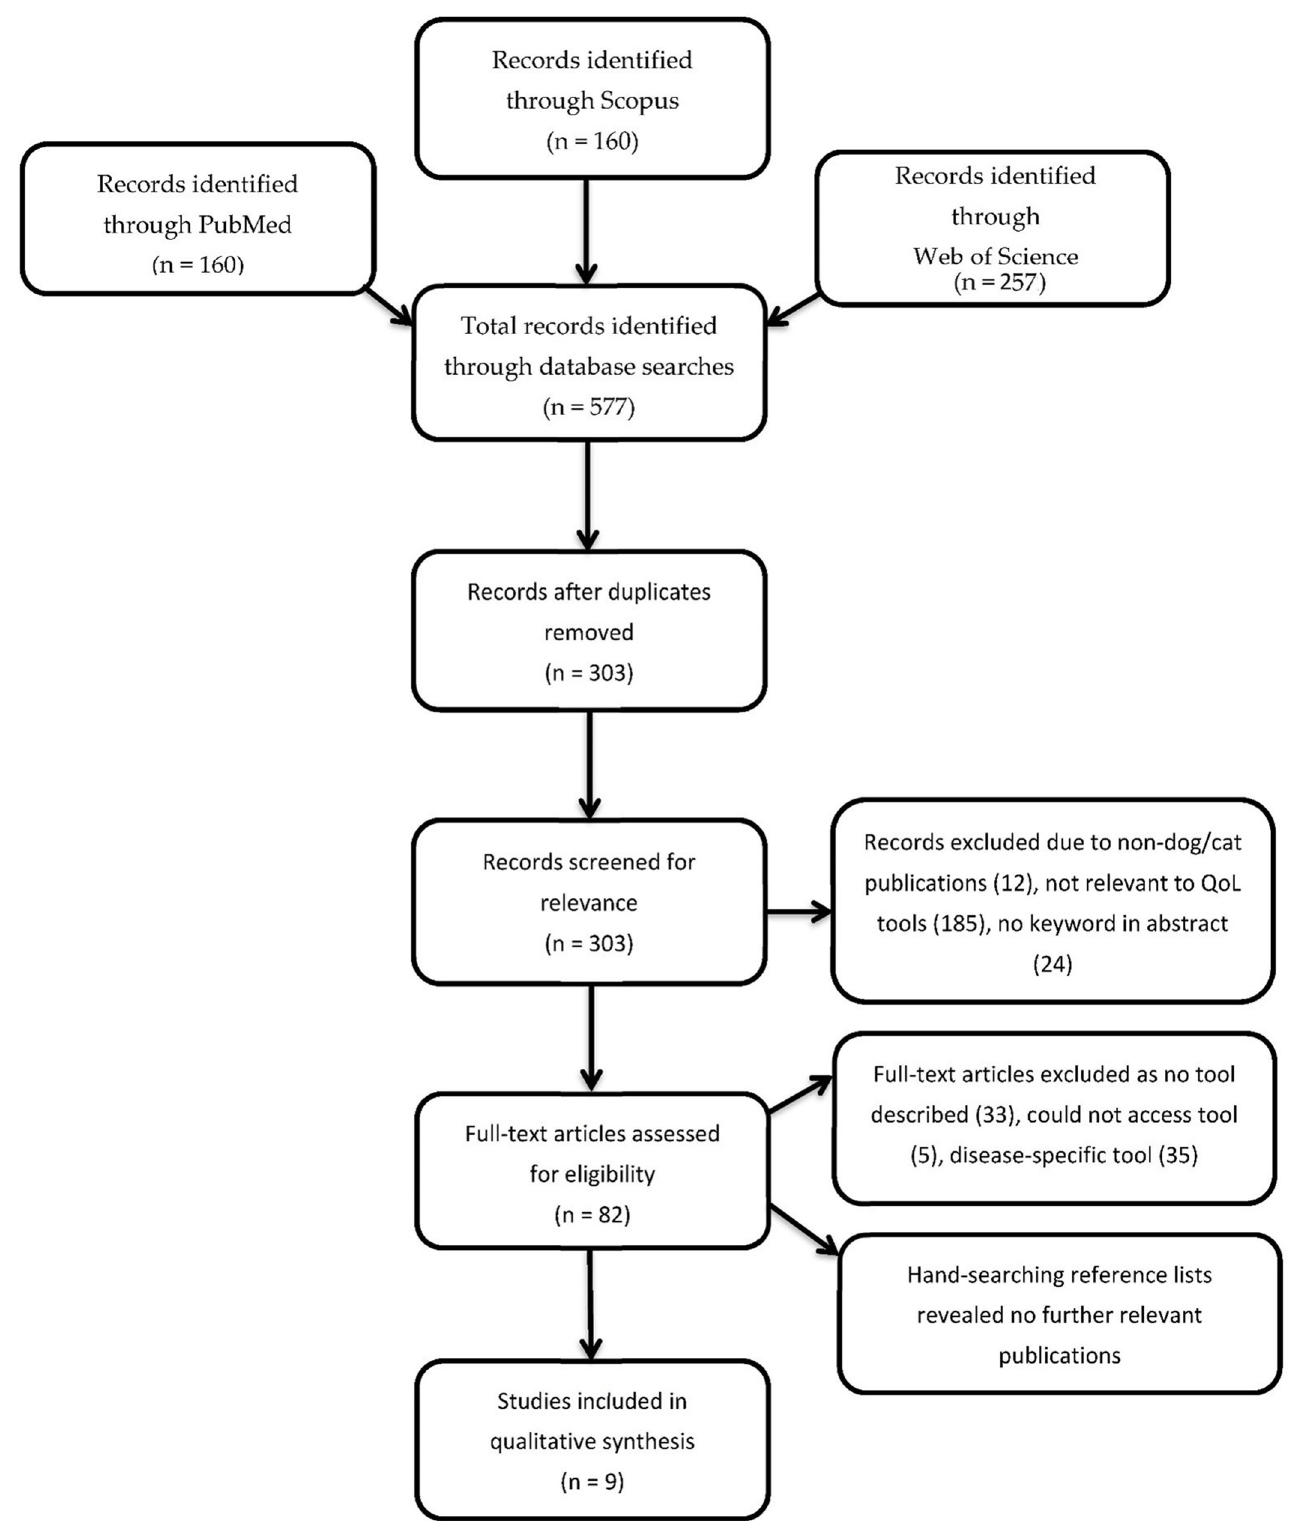
Figure 1. Summary of the systematic approach to the literature using a PRISMA flow diagram [28].